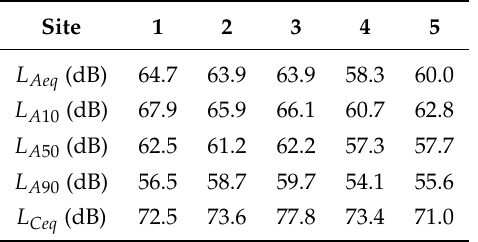
Table 2. Acoustic parameters for the five